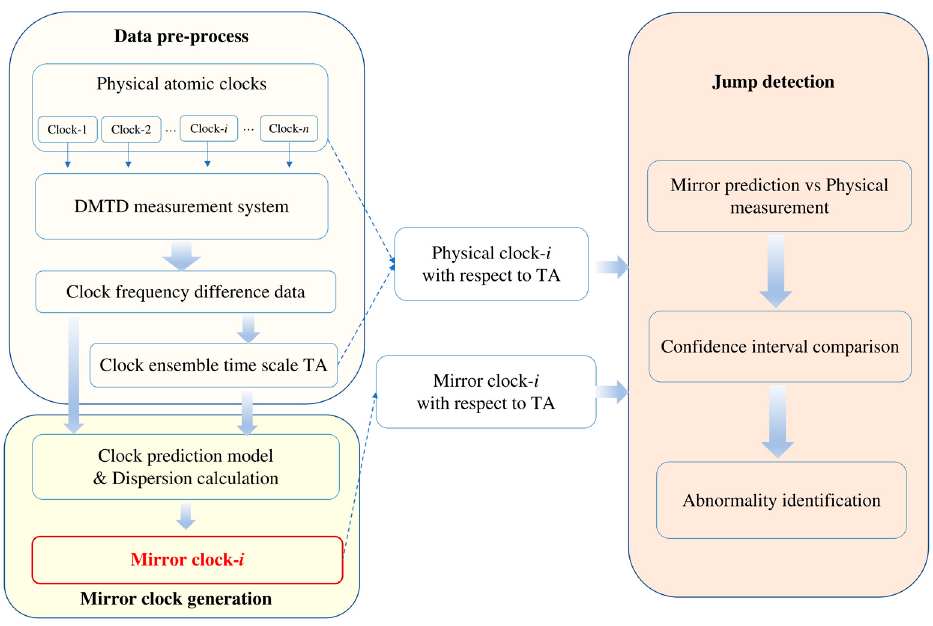
Figure 1. Mirror clock implementation flowchart.